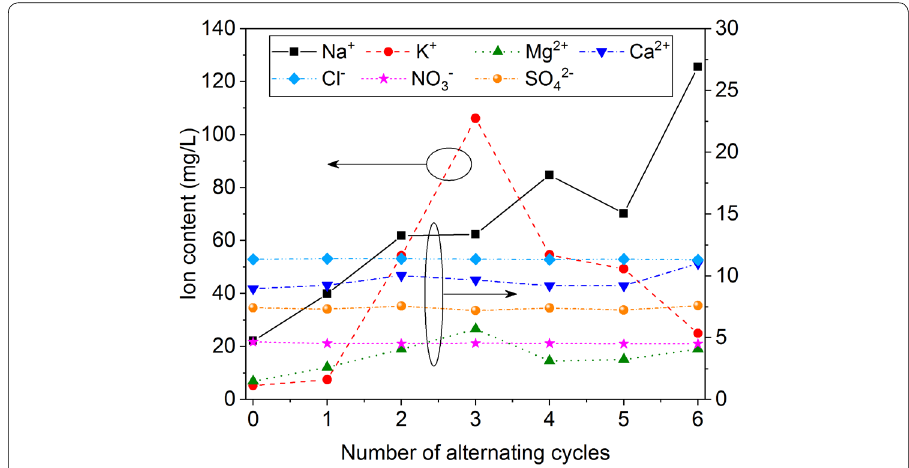
Fig. 12 Ion content changes in each alternating